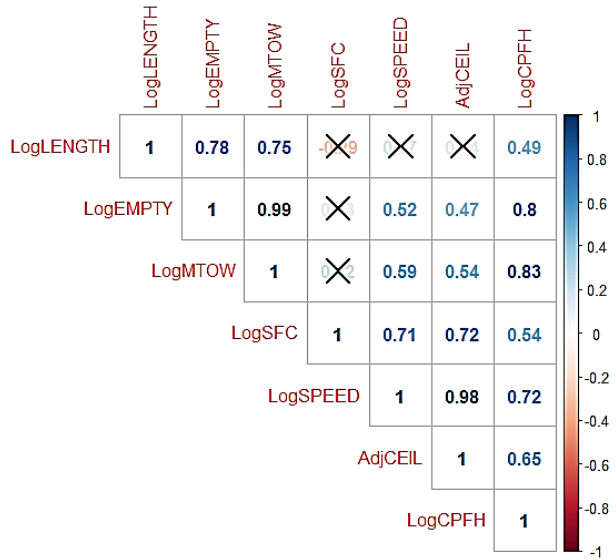
Figure 4. The variables correlation (Pearson) matrix. The symbol “×” indicates the insignificant correlations at the 5% significance level. Multicollinearity is evident among several independent variables.